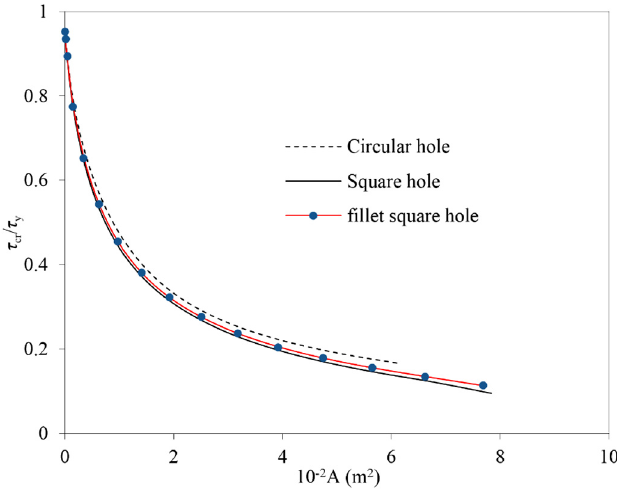
Fig. 10. The in fl uence of the hole ’ s area on critical stress ( t = 2.5mm, b = 300mm).